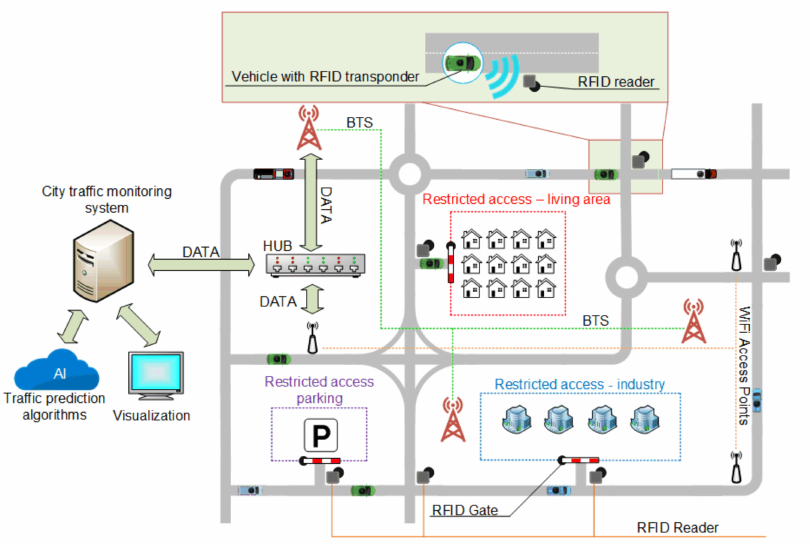
Figure 5. City tra ffi c detection infrastructure with RFID transponders installed inside a